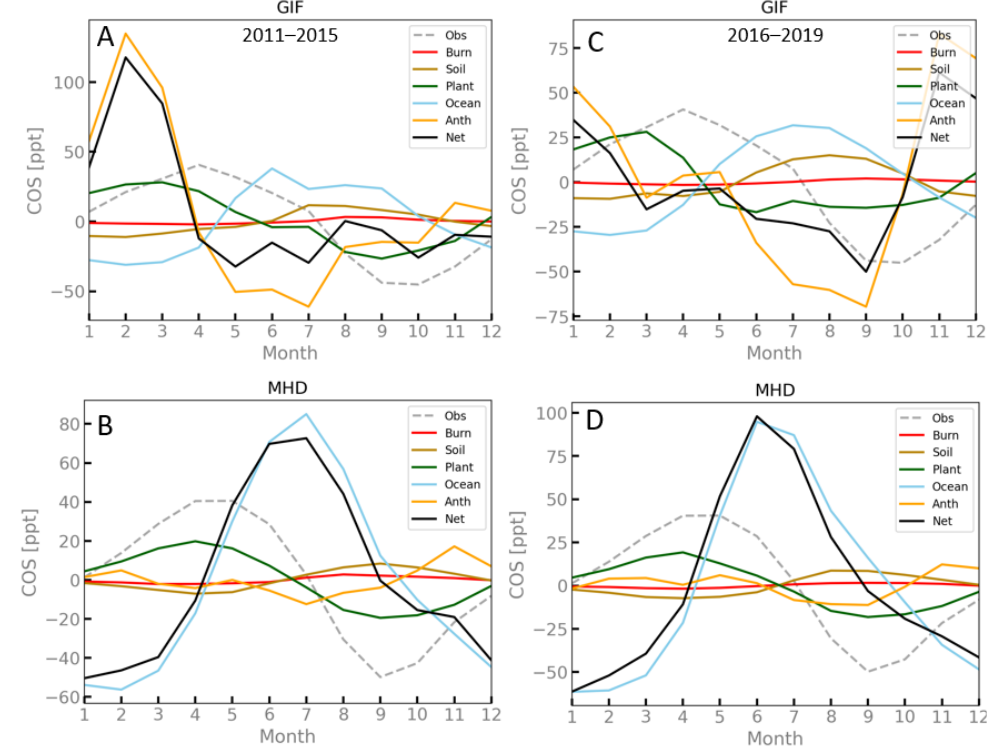
Figure 4. Simulations of the mean seasonal cycle of tropospheric COS mixing ratios over the years 2011–2015 (left column, NH mean annual atmospheric COS concentration in the range 483.7–491.5 ppt) and 2016–2019 (right column, decreasing NH mean annual atmospheric COS concentration in the range 486.9–467.8 ppt, see Figure 3) at the GIF ( A , C ) and MHD ( B , D ) monitoring stations. Detrended seasonal cycles were calculated by subtracting the long-term trend from the smooth curve, and then averaged. These simulations only account for the first-order relationship between the COS plant/soil fluxes and NH mean annual atmospheric COS concentrations. The net signal (black line) was obtained from a global LMDz simulation using all the dominant sources and sinks, while the signal components (colored lines) were obtained by running the global atmospheric simulation with one component flux at a time. Observations are shown in grey (dashed line). The time series of COS mixing ratios were detrended and filtered to remove the synoptic variability (see Section 2). An identical plot using optimized marine COS emissions is shown in Figure S1 for comparison.